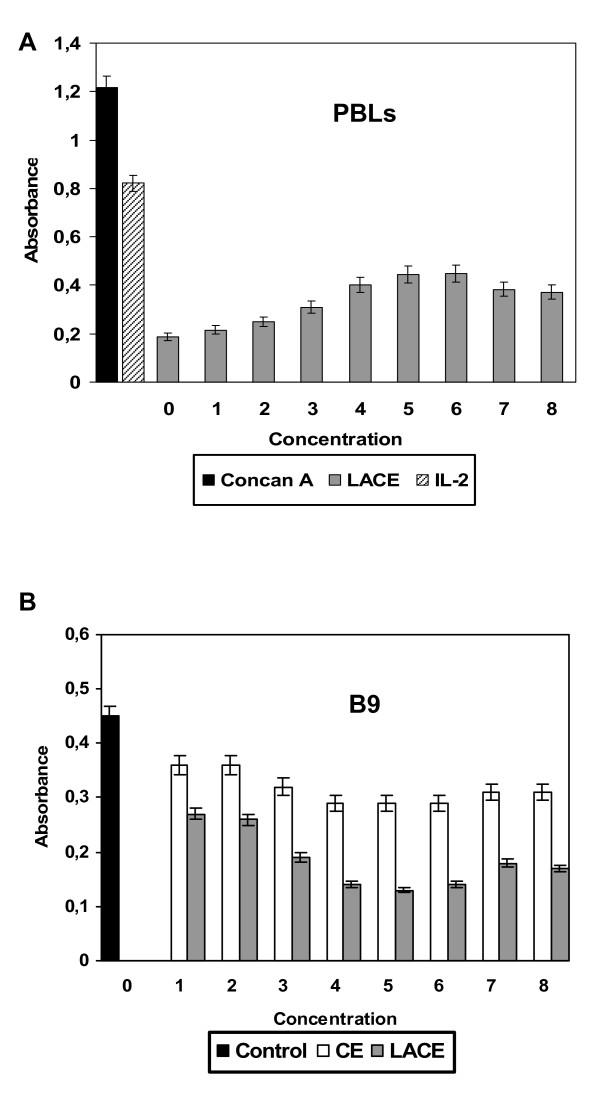
Dose-response effect of LACE extract in PBLs and B9 fibrosarcoma murine cell line. a) PBLs were cultured in medium alone or with various concentrations of LACE extract from 2 mg/ml (conc. 8) to 15.62 μg/ml (conc. 1) for 72 h. b) For B9 tumor cells were cultured with culture medium alone or various concentrations of LACE or CE for 72 h. Each column represents the mean of five independent experiments ± SD.